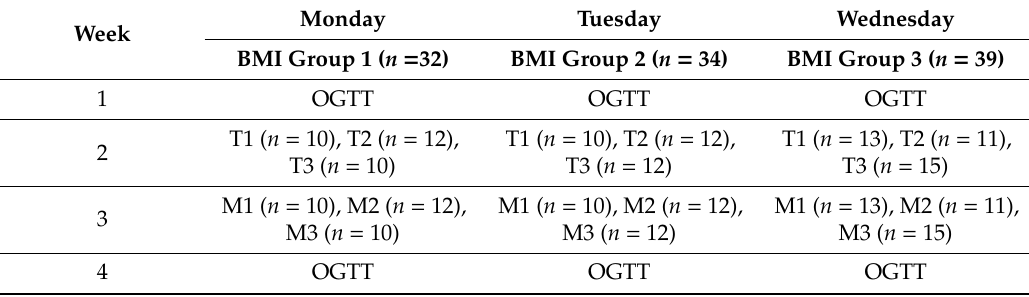
Table 2. Schedules of the oral glucose tolerance test and the administration of test